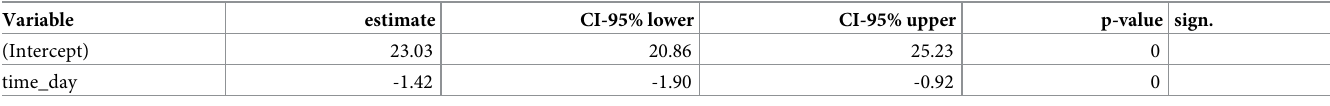
Table 3. Results of final LME model on DRS-R-98 total